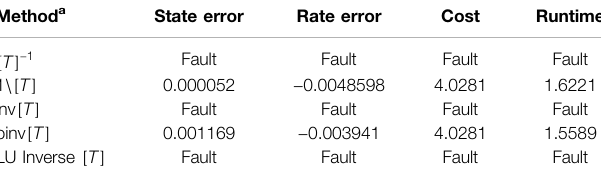
TABLE 1 | Double-integrator plant ten-run mini-Monte Carlo analysis (faults occurredafter fi rstsimulationrun)executedinMATLAB ® /SIMULINK ®